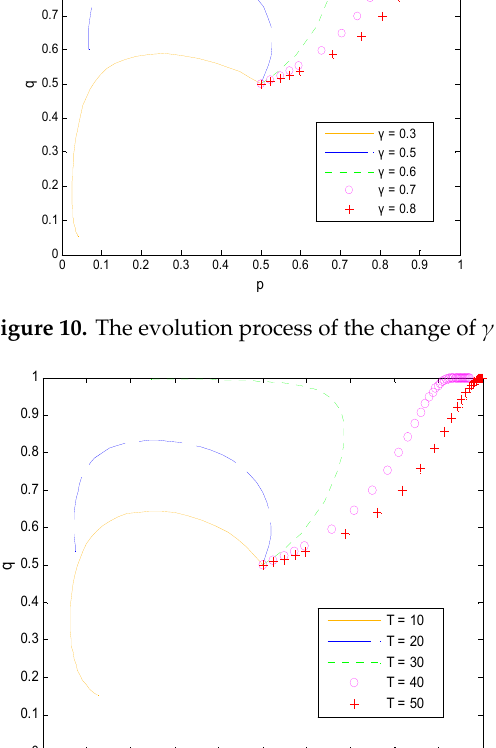
Figure 10. The evolution process of the γ . change of